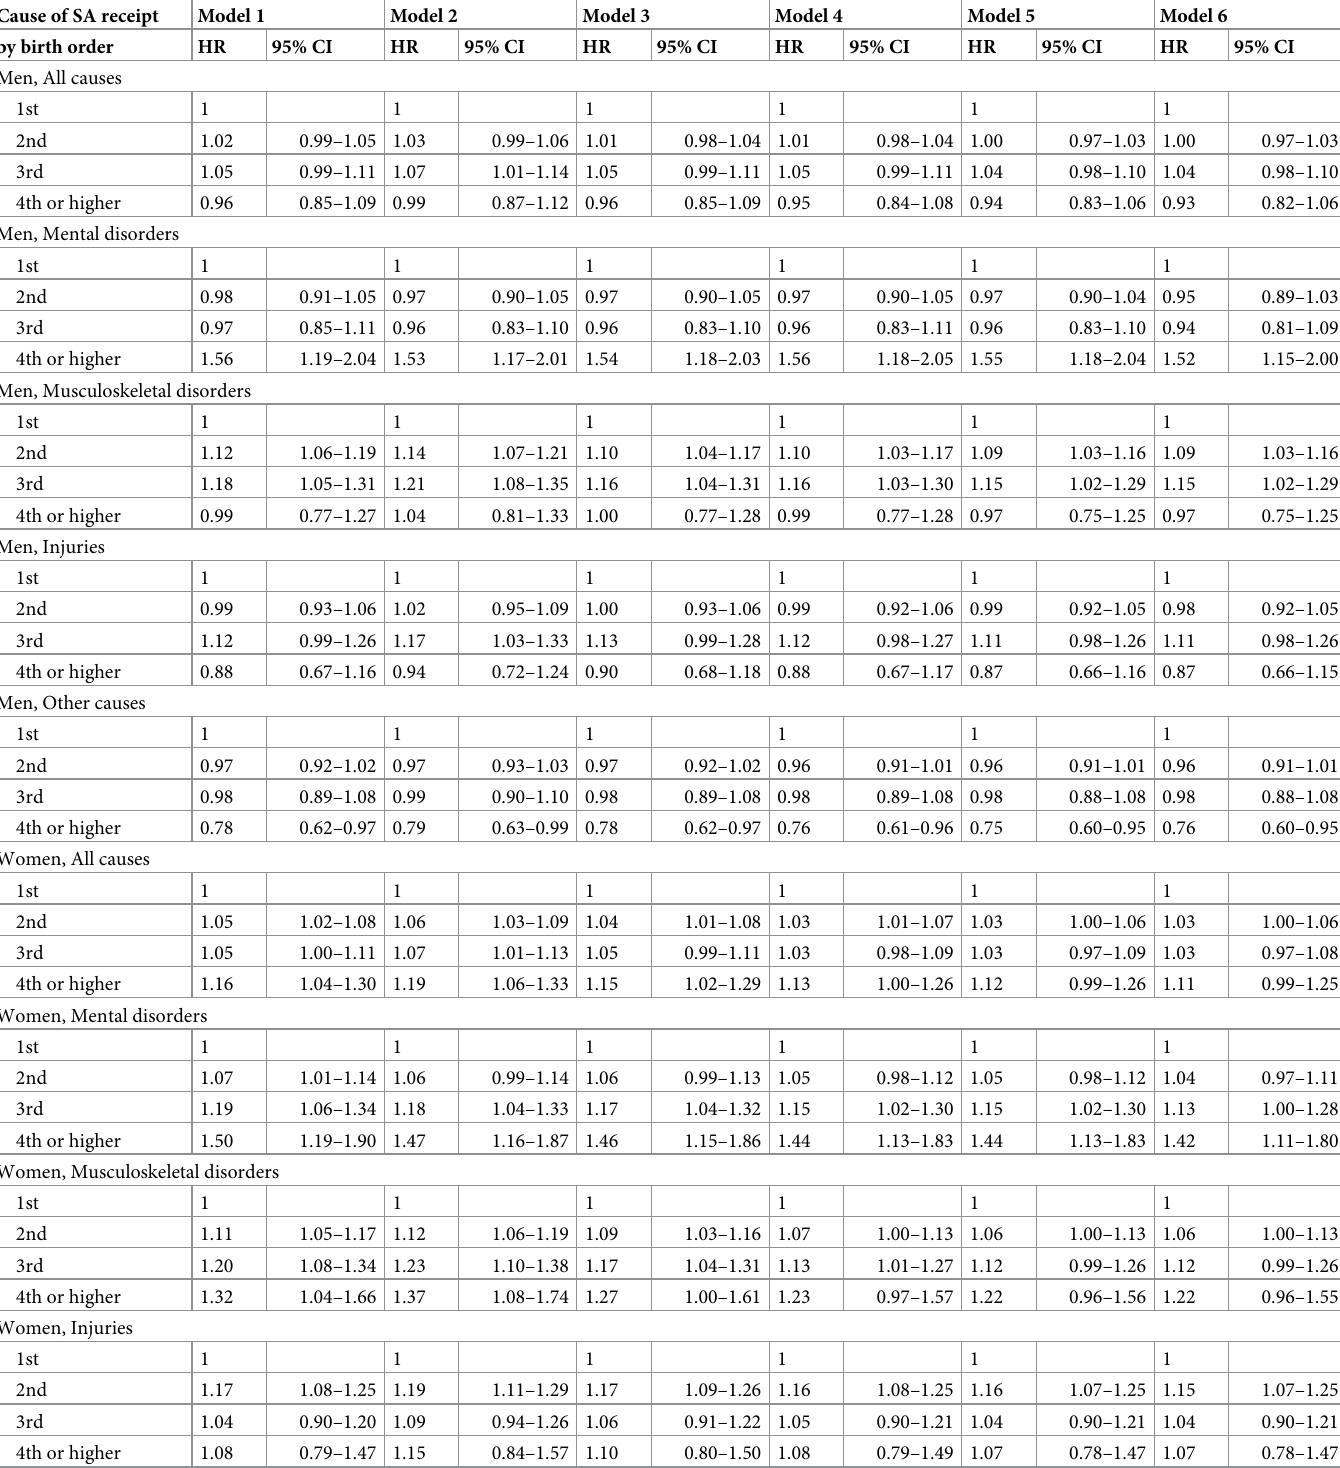
Table 3. Hazard ratios with 95% confidence intervals for estimated associations of birth order and sickness absence by sex, results from Cox regression models stratified by shared mother and father